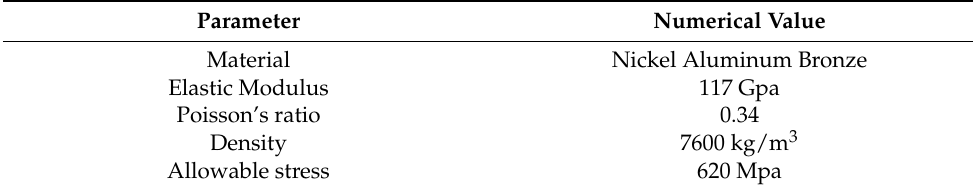
Table 4. Material model of pump-jet propulsion